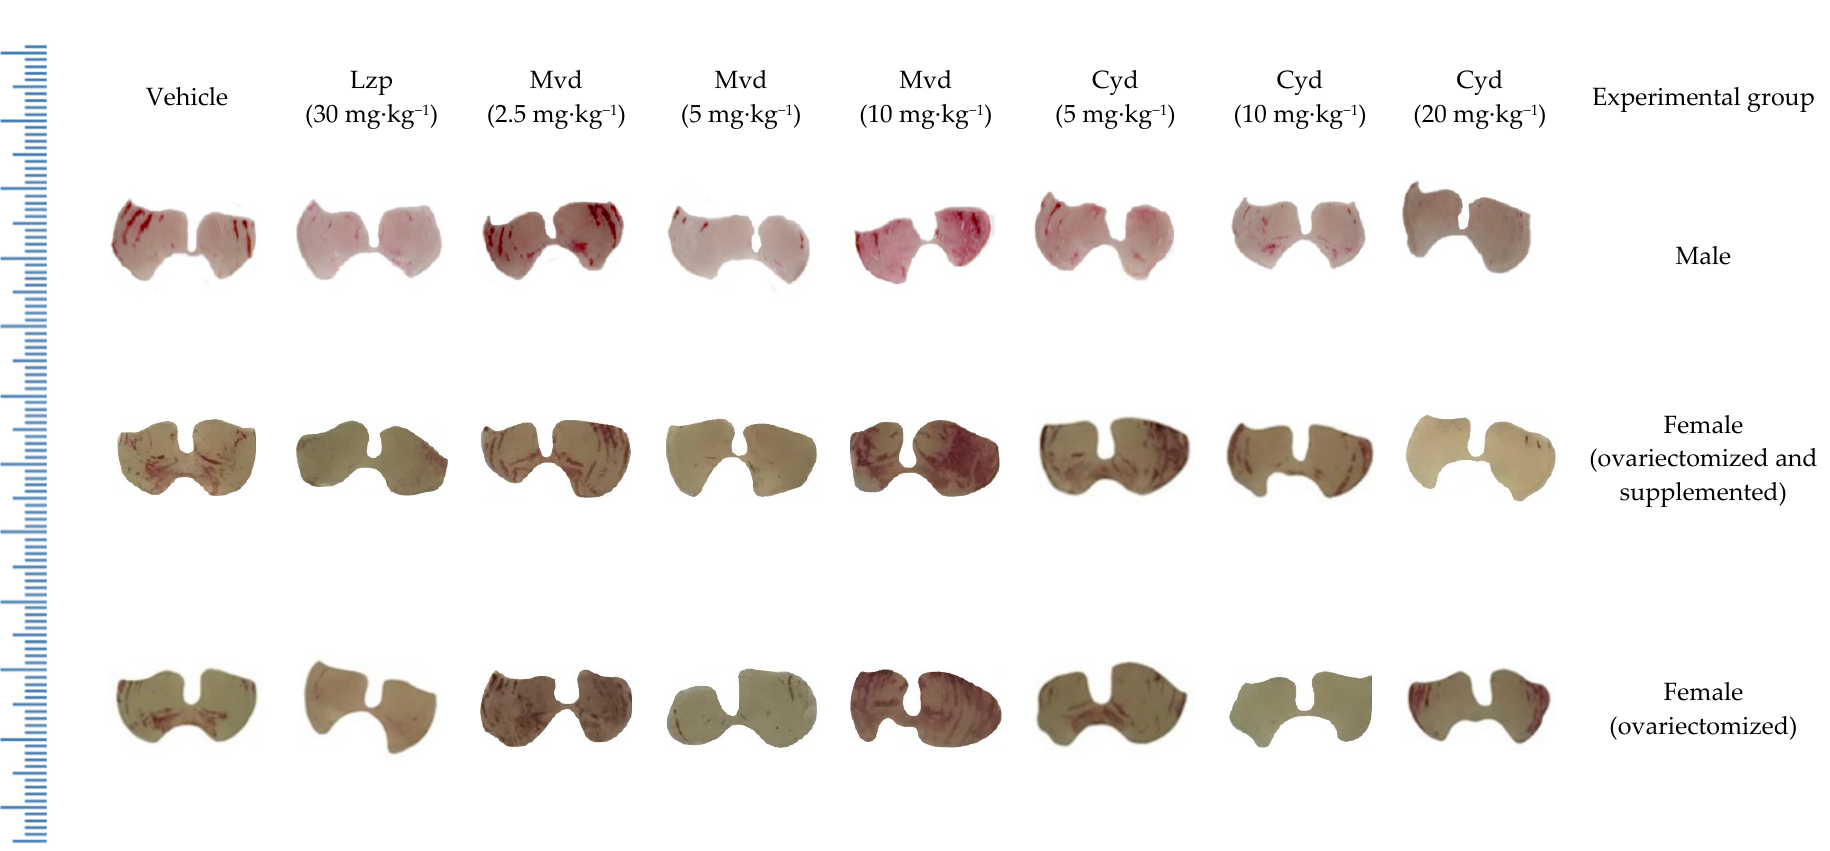
Figure 4. Representative panel with images of mice stomachs treated with vehicle, lansoprazole, malvidin, and cyanidin and submitted to the protocol of gastric ulcer induced by ethanol.